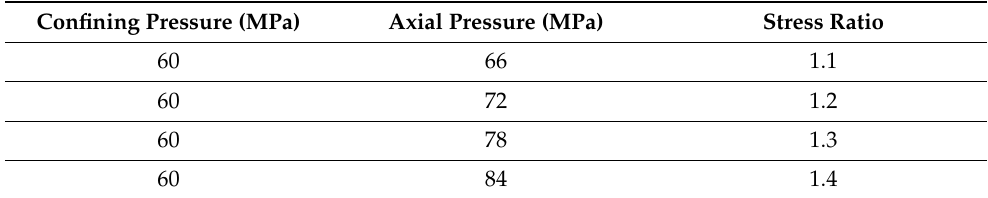
Table 5. The experimental scheme for sample No.